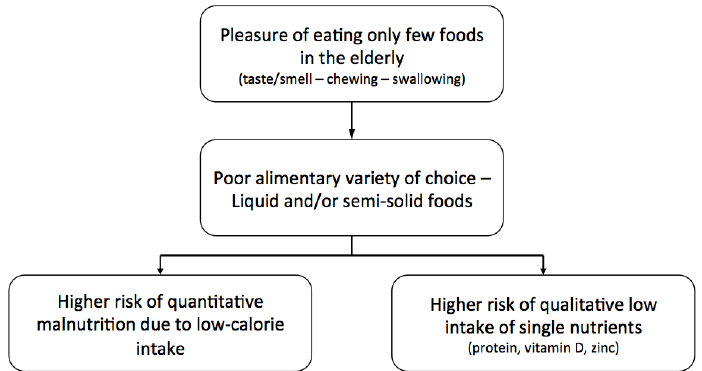
Figure 2. Anorexia of aging and risk of malnutrition.